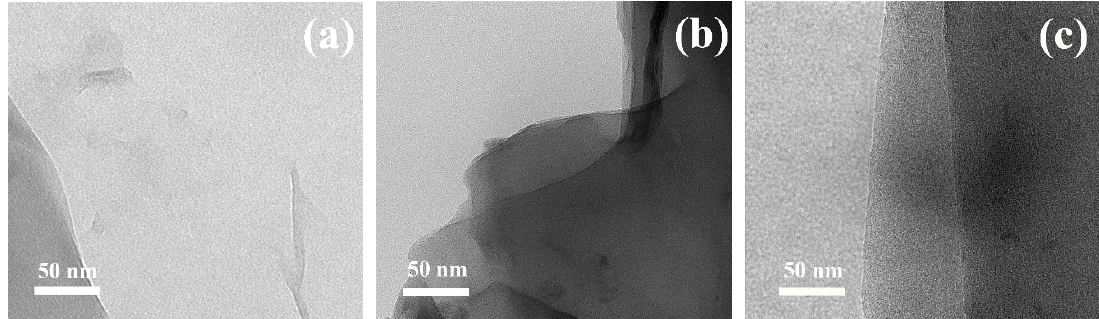
Figure 2. TEM images of ( a ) neat GO; ( b ) GO-PGMA; and ( c ) GO-PGMA-2.